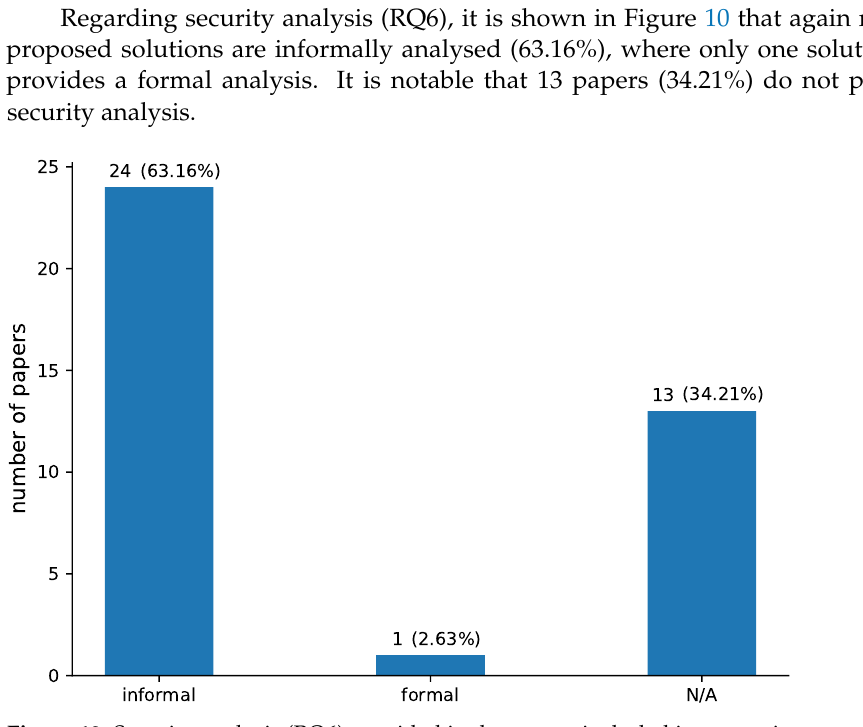
Figure 10. Security analysis (RQ6) provided in the papers included in our